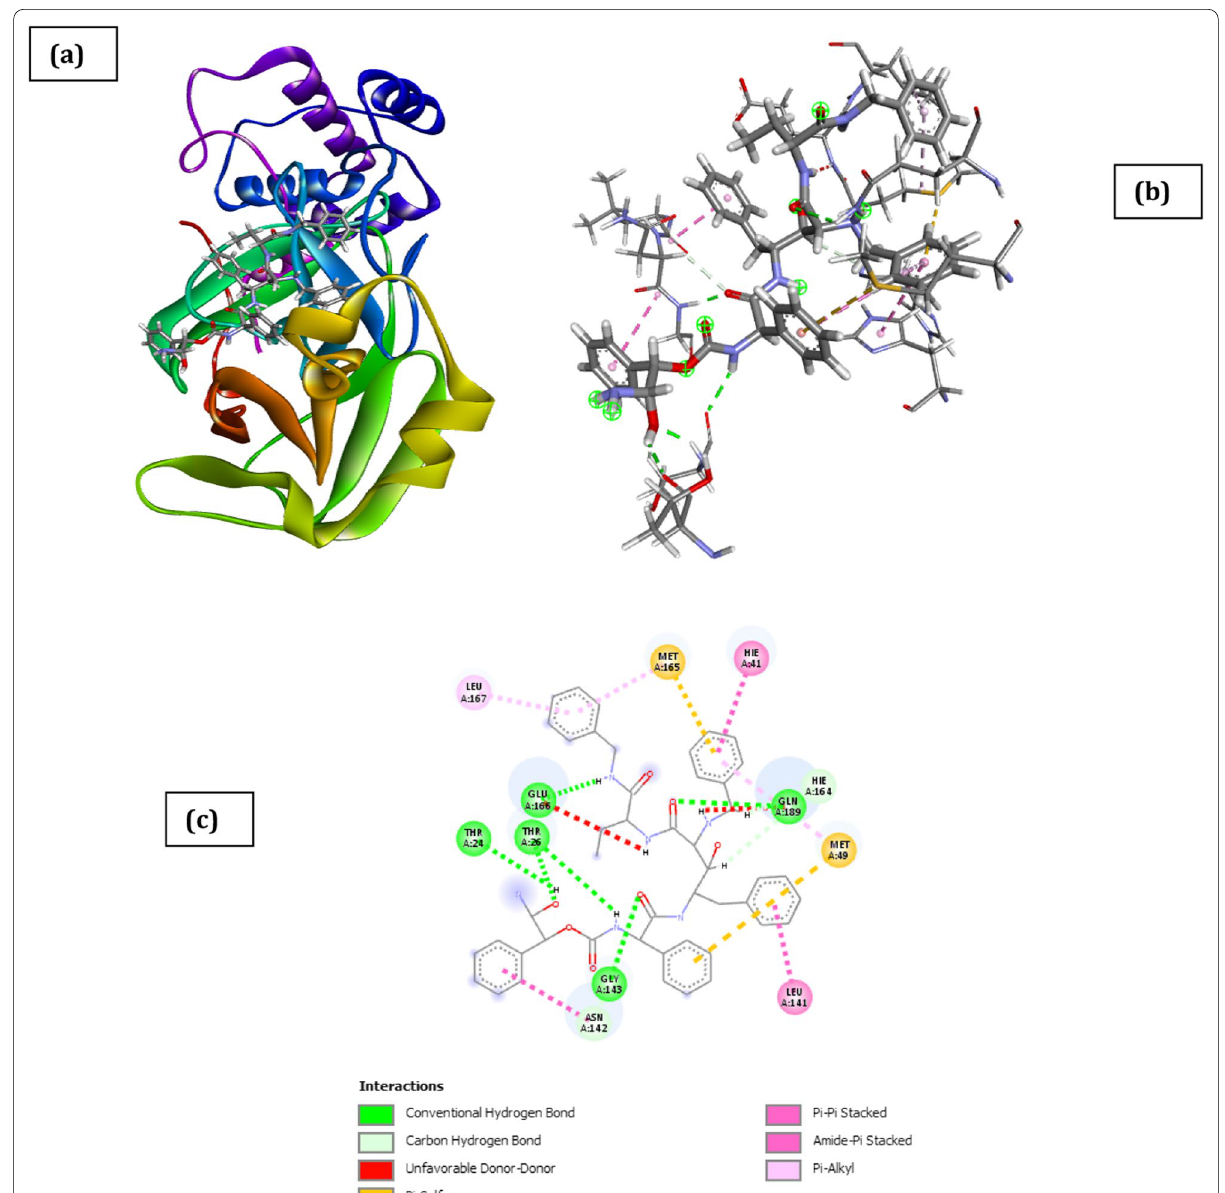
Fig. 9 Docked poses of SARS CoV 2 main protease (PDB ID: 6XBH) with inhibitor with Index number 741a (stick figure) a 3D view of docked pose of SARS CoV 2 Main Protease (PDB ID: 6XBH) with inhibitor with Index number 741a; b 3D view of inhibitor with Index number 741a with surrounding amino acids of 6XBH; c 2D view of interaction type of inhibitor with Index number 741a with surrounding amino acids of